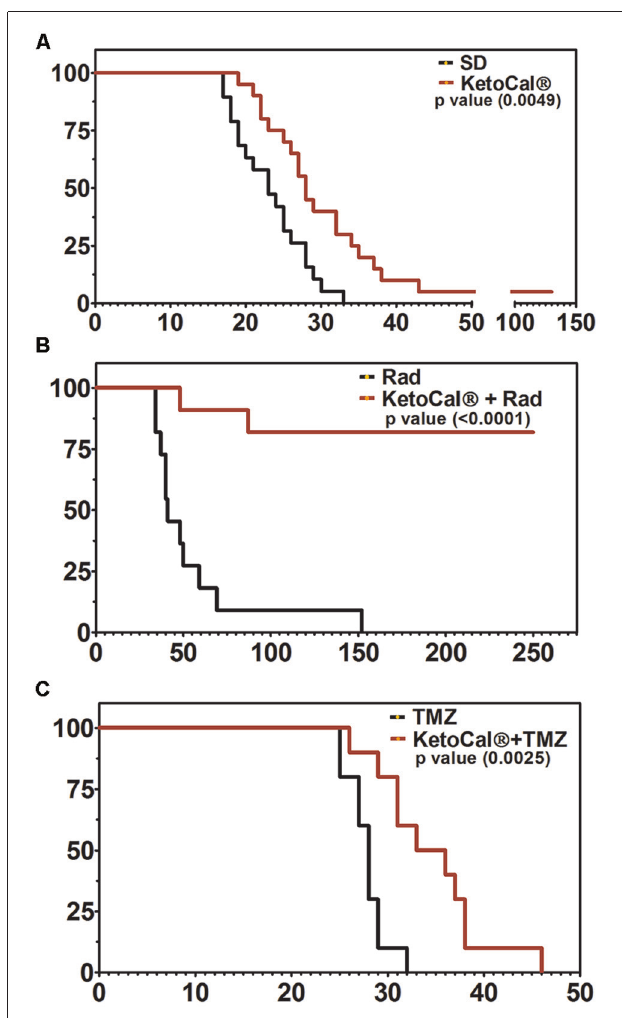
FIGURE 2 | Kaplan-Meier survival plot of animals implanted intracranially with GL261-luc2 malignant glioma cells and (A) maintained on KetoCal (cid:114) [KC, the 4:1 fat:carbohydrate plus protein formulation of the ketogenic diet (KD)] vs. standard diet (SD); (B) treated with 2x4Gy radiation vs. KC plus radiation, and (C) treated with 50 mg/kg temozolomide (TMZ) vs. KC plus TMZ. Animals on KC survived significantly longer when treated with KC alone, when KC was combined with radiation, and when KC was combined with TMZ (Scheck et al., 2011; Abdelwahab et al., 2012).